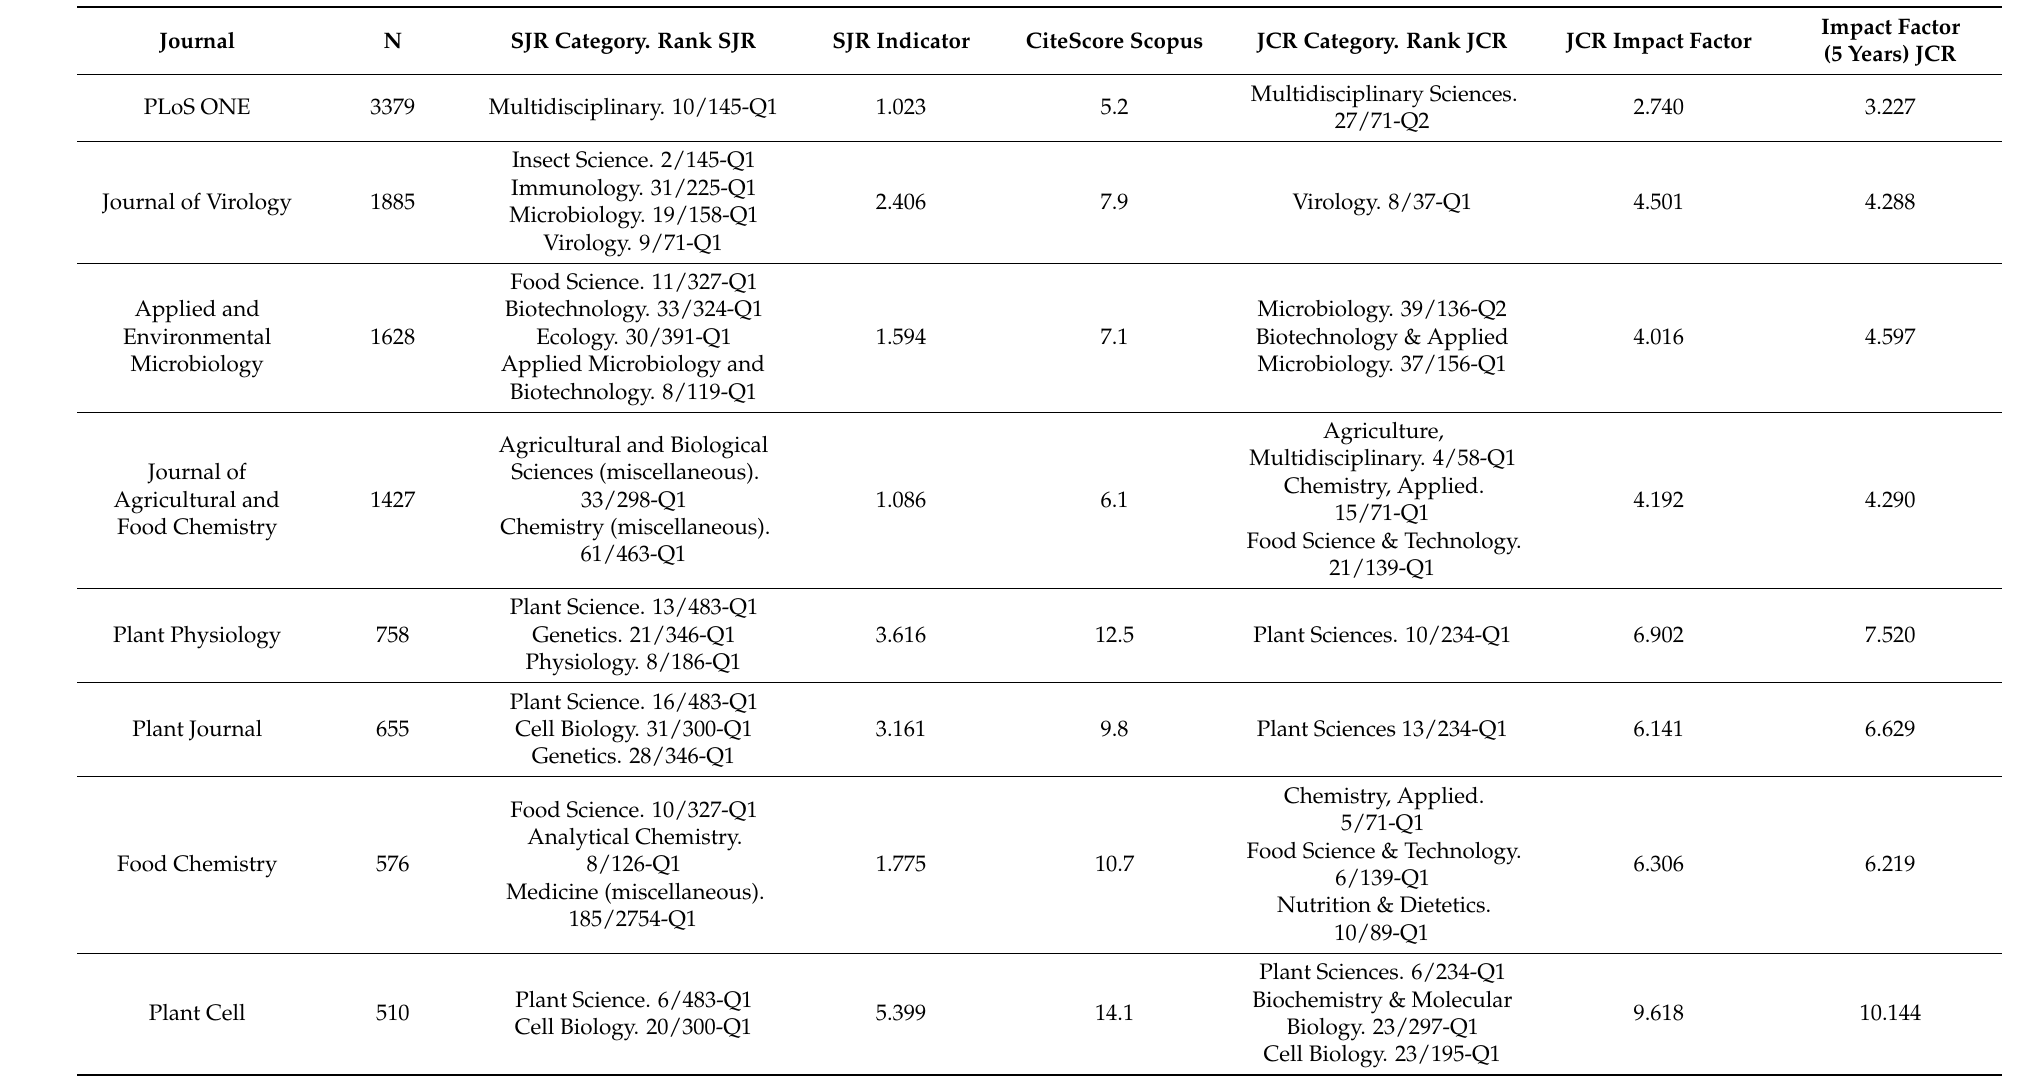
Table 2. Top 20 journals and their metrics. (Data